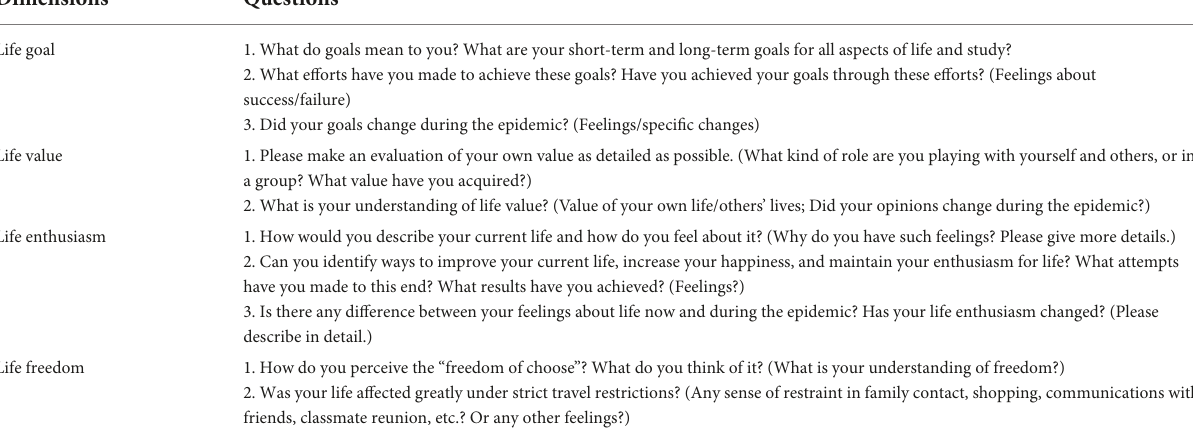
TABLE 2 Interview outline on Chinese undergraduates’ life meaning in the post-epidemic period.